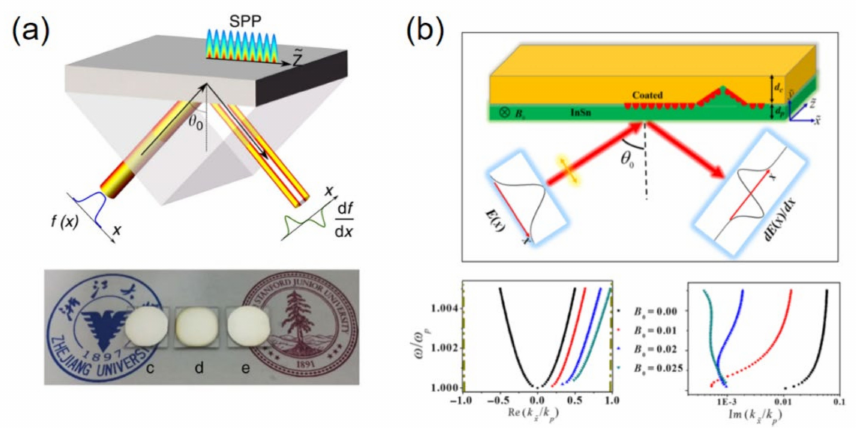
Figure 5. ( a ) Top: schematic of the surface-plasmon-based scheme to perform spatial differentiation with the Kretschmann configuration. Bottom: photograph of the three samples with different thicknesses; adapted with permission from [135], Springer Nature, 2017. ( b ) Top: schematic of the backscattering-immune first-order spatial differentiator based on nonreciprocal plasmonic platform. Bottom: the simulated results of real and imaginary parts of the eigenvector with different external magnetic fields. Adapted with permission from [137], APS,